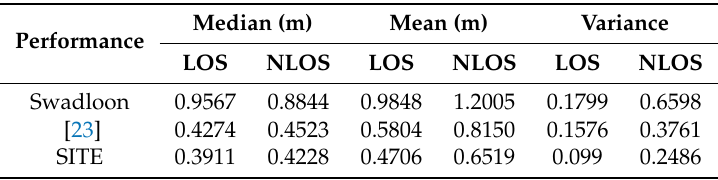
Table 2. Performance on median error, mean error and variance